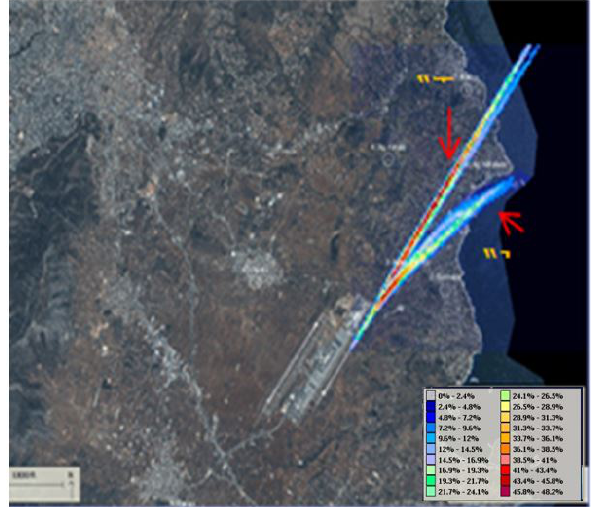
Figure 3: Juliet vs Tango